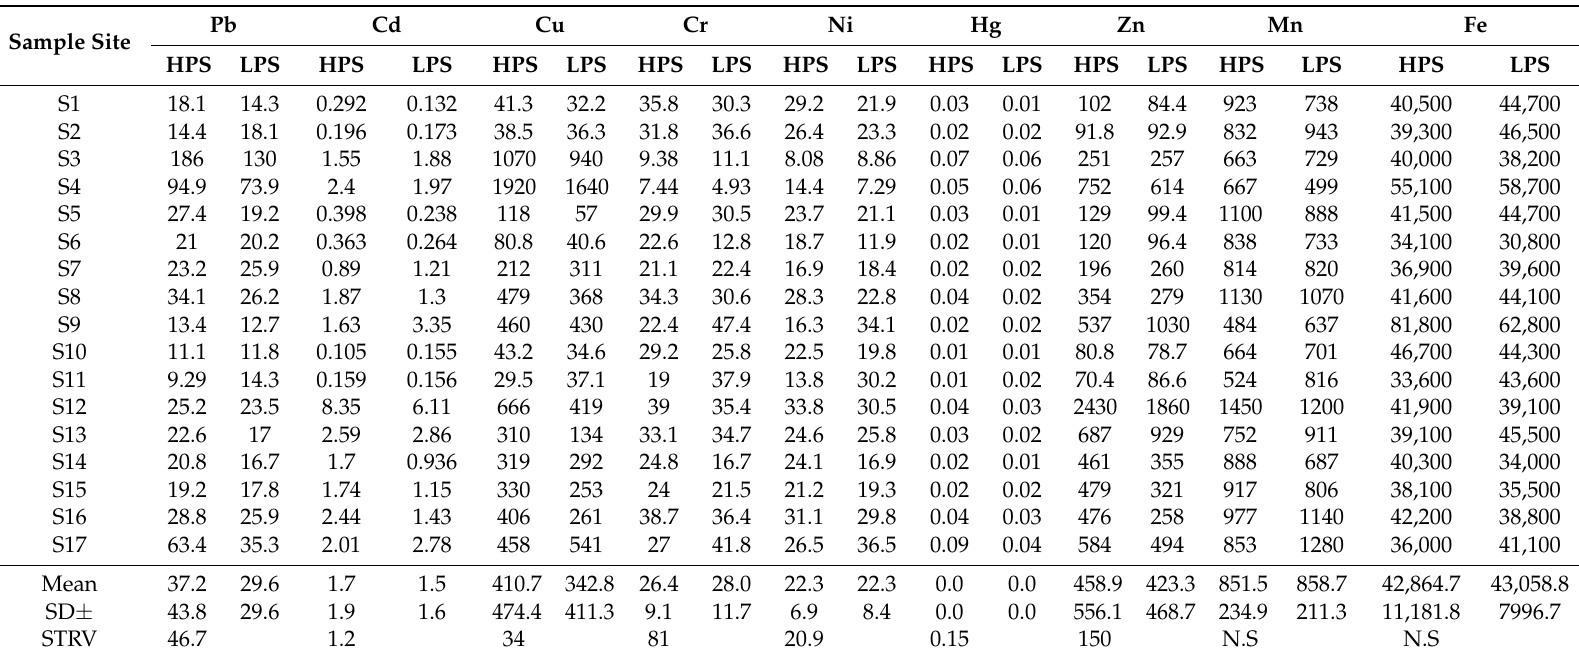
Table 5. Heavy metal concentrations in sediments (mg/kg) at all sample sites in both